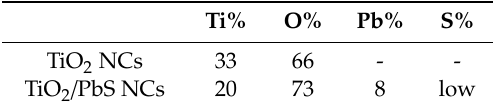
Table 1. STEM-EDS analysis (atomic %) of TiO 2 NCs and TiO 2 / PbS hybrid